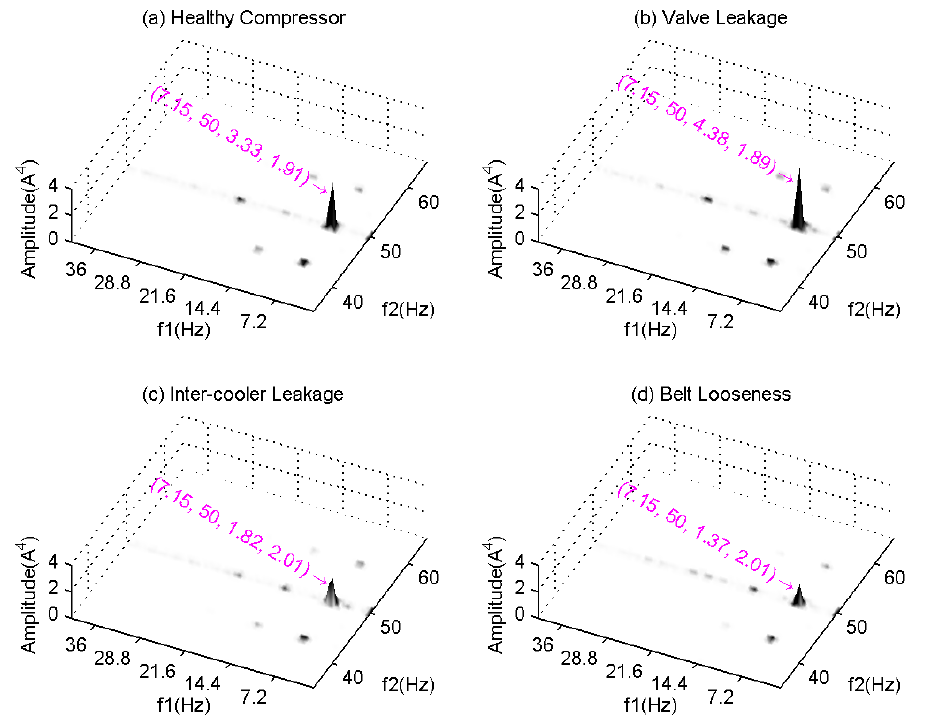
Figure 12. MSB amplitudes for different conditions of the reciprocating compressor.